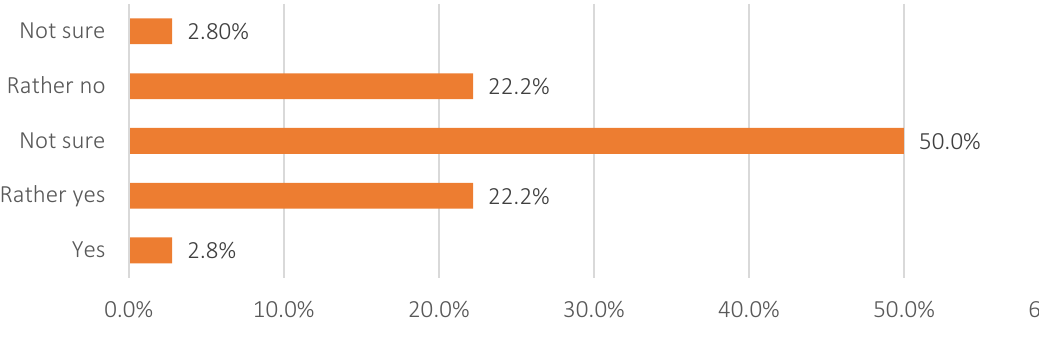
Figure 2. Do Ukrainian insurance companies implement